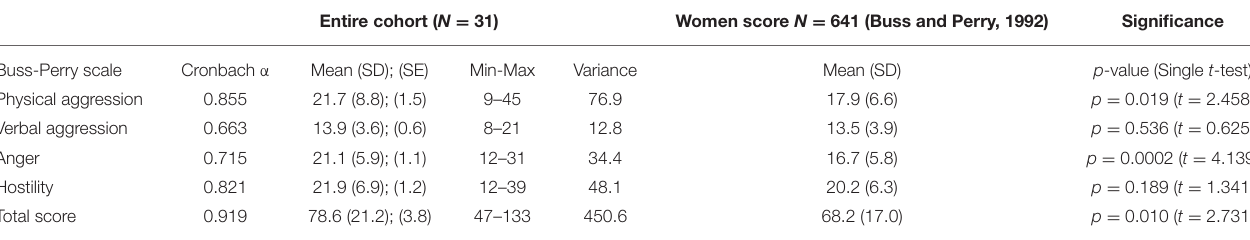
TABLE 2 | Results of the Buss-Perry test.